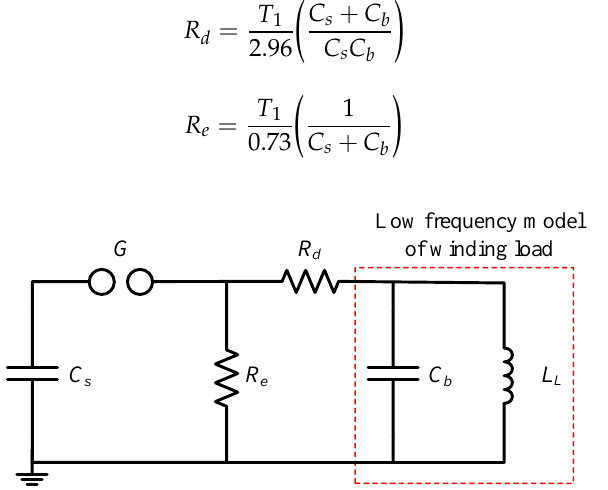
Figure 2. Conventional generator circuit used in the lightning impulse voltage tests, where C s is a charging capacitor, G is a spark gap, R e is a tail time resistor, R d is a front time resistor, C b is a load capacitor, and L L is a load inductor.